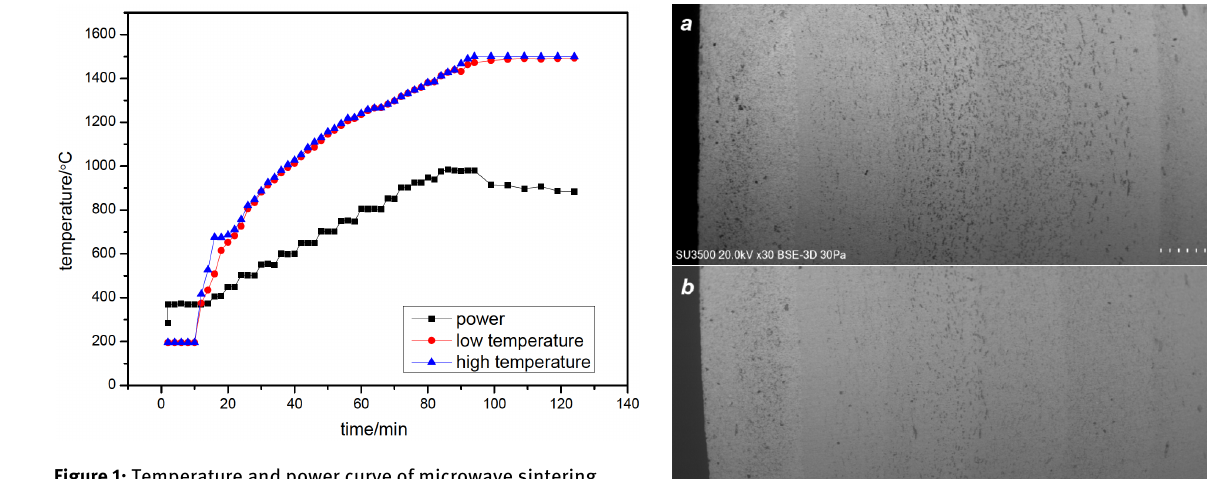
Figure 1: Temperature and power curve of microwave sintering process